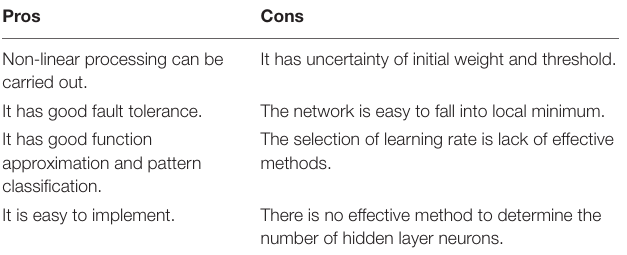
TABLE 2 | Pros and cons of